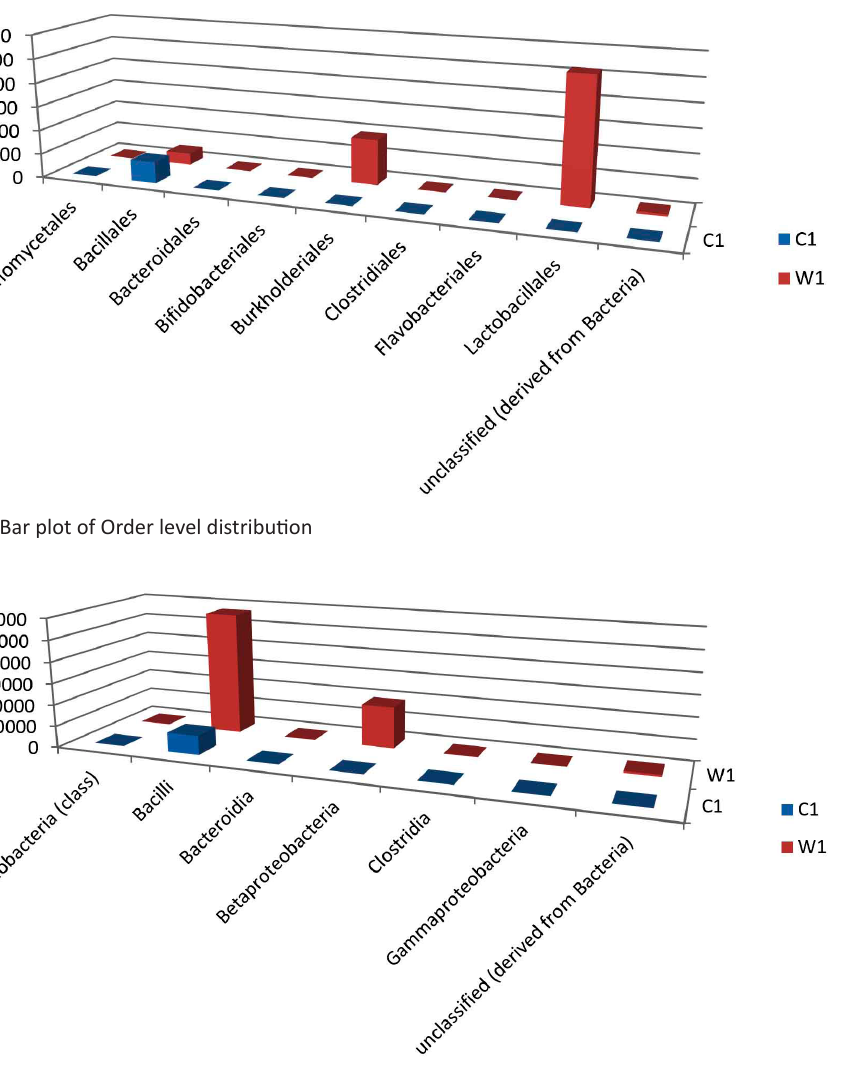
Fig. 7. Krona plot of Class level